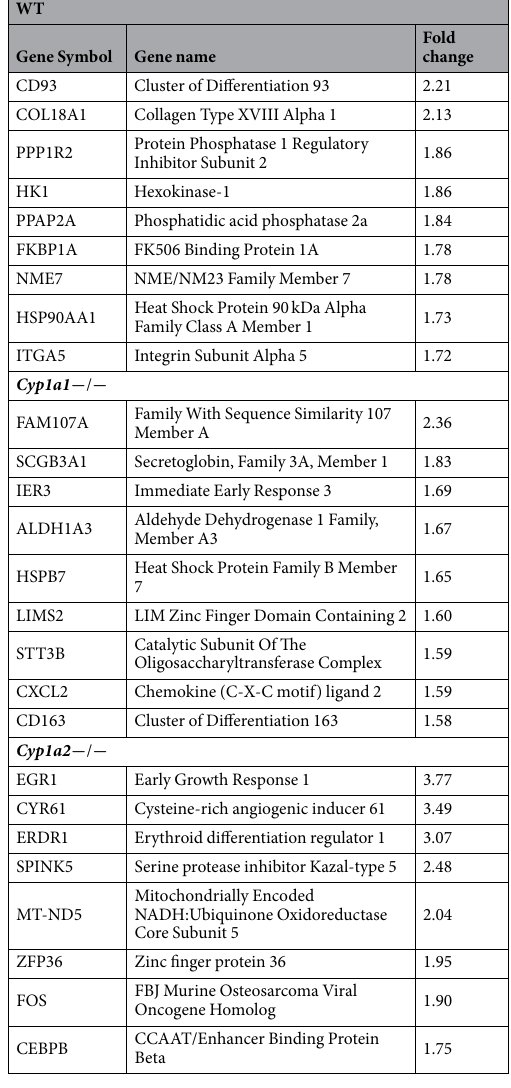
Table 1. Up regulated genes exclusive to a given genotype (Hyperoxia exposed mice compared to room air WT and Cyp1a knockout animals under hyperoxic conditions are listed in supplemental data Table S5 and those between hyperoxia exposed and room air controls in each respective genotype are listed in Table S6. Many of the significantly changed proteins detected by the RPPA assay were post-translationally modified, and as such their expression may not have been assessed as significantly changed in the microarray profile. Real time qPCR validation.